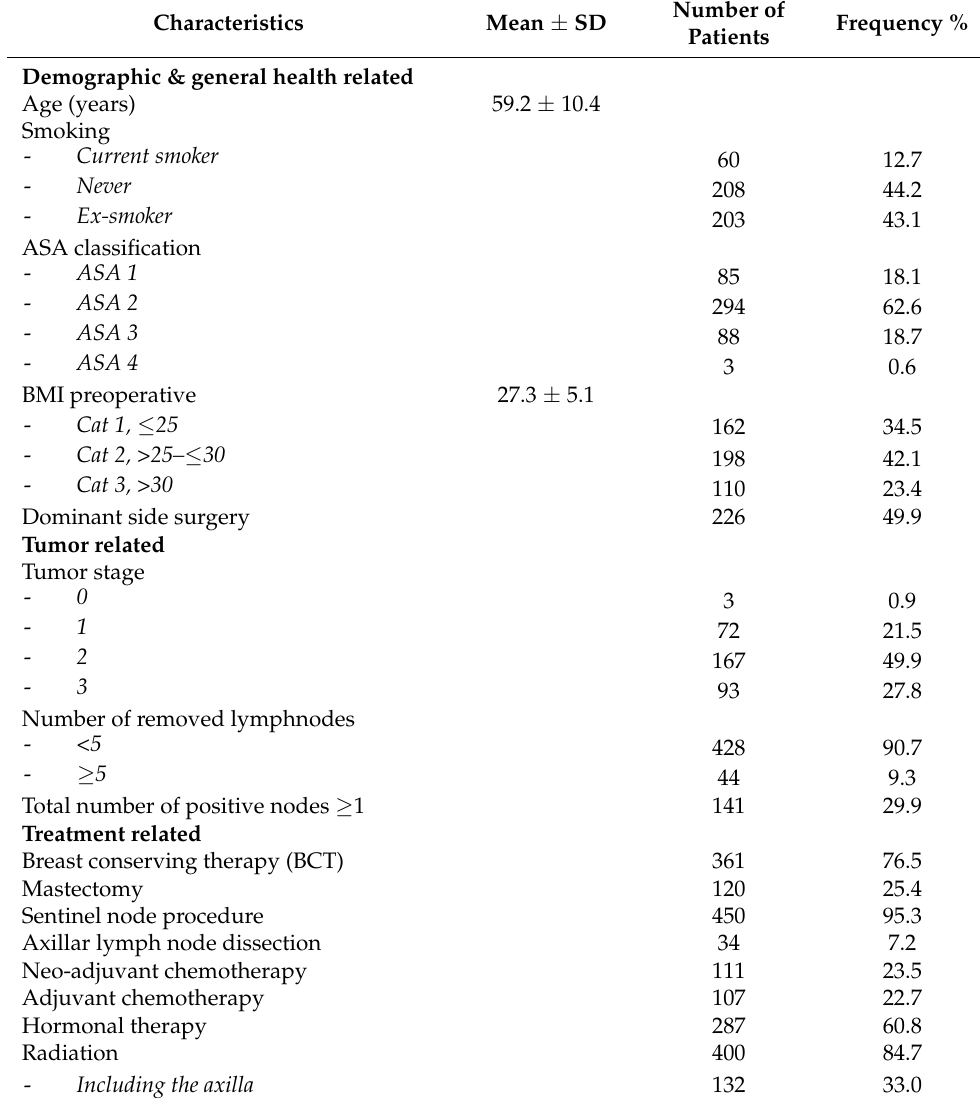
Table 1. Patient characteristics.